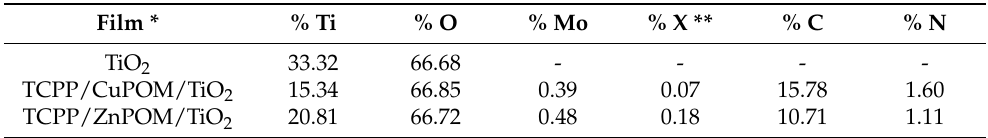
Figure 3. Cross-section SEM ×18,000 image of the TiO 2 films. SEM ×13,000 images of the films: ( b ) Figure 3. ( a ) Cross-section SEM × 18,000 image of the TiO 2 films. SEM × 13,000 images of the films: TiO 2 ., ( c ) TCPP/CuPOM/TiO 2 and ( d ) TCPP/ZnPOM/TiO 2. ( b ) TiO 2 , ( c ) TCPP/CuPOM/TiO 2 and ( d ) TCPP/ZnPOM/TiO 2 . Table 1. Elemental composition analysis where Mo/X is the atomic relation between molybdenum and the Cu or Zn